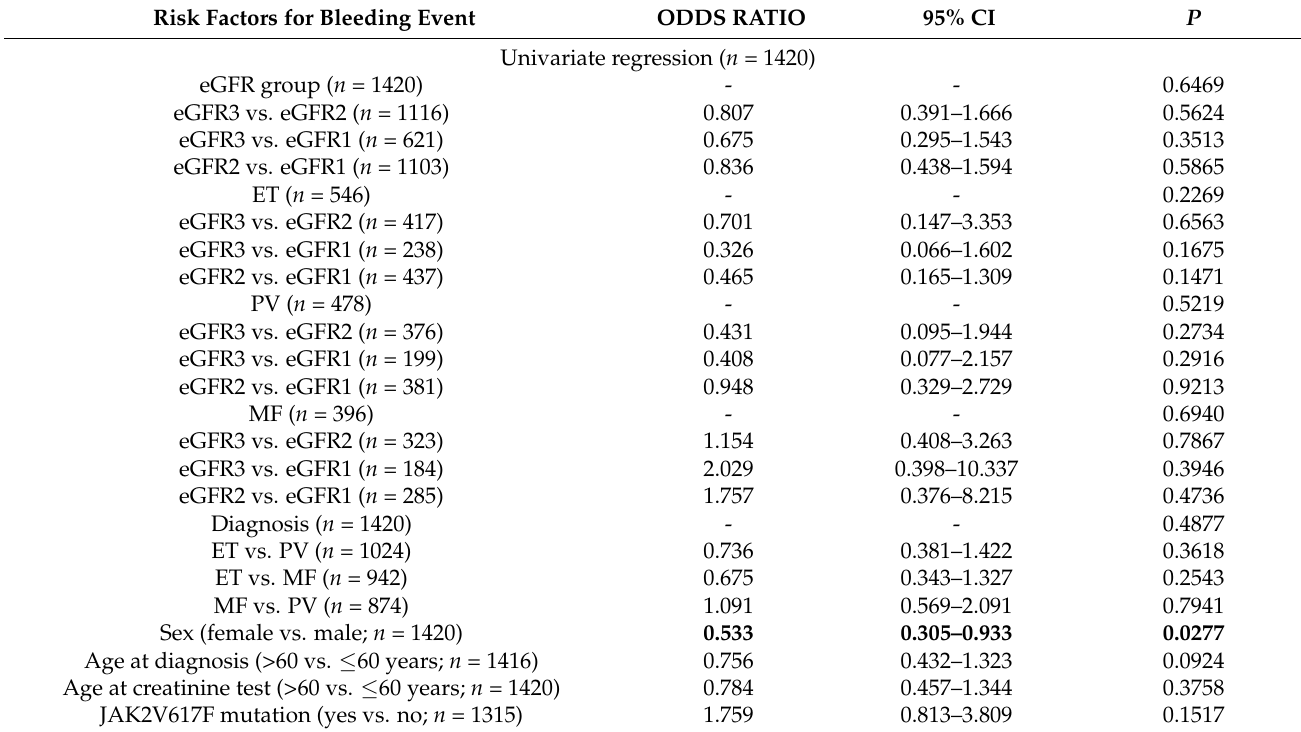
Table 4. Risk factors for severe bleeding ( n = 55) among all patients and eGFR